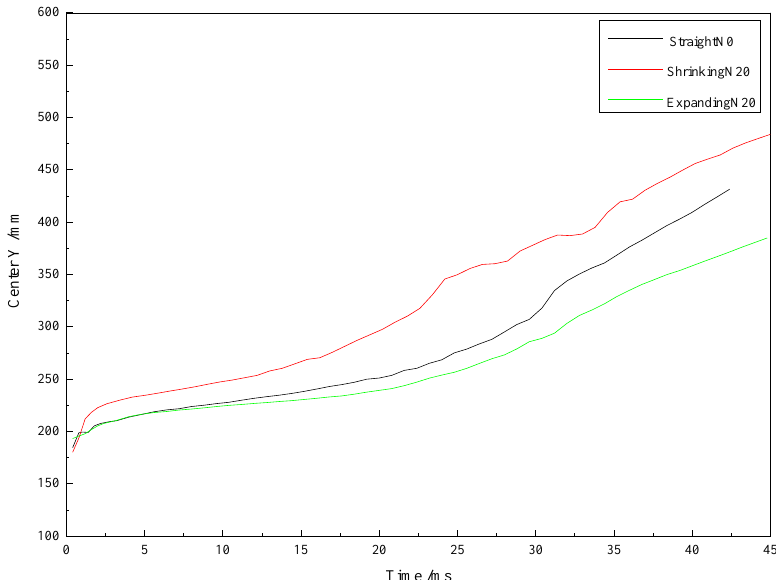
Figure 13. Curves of the bubble centroid-Y when different nozzles were installed.